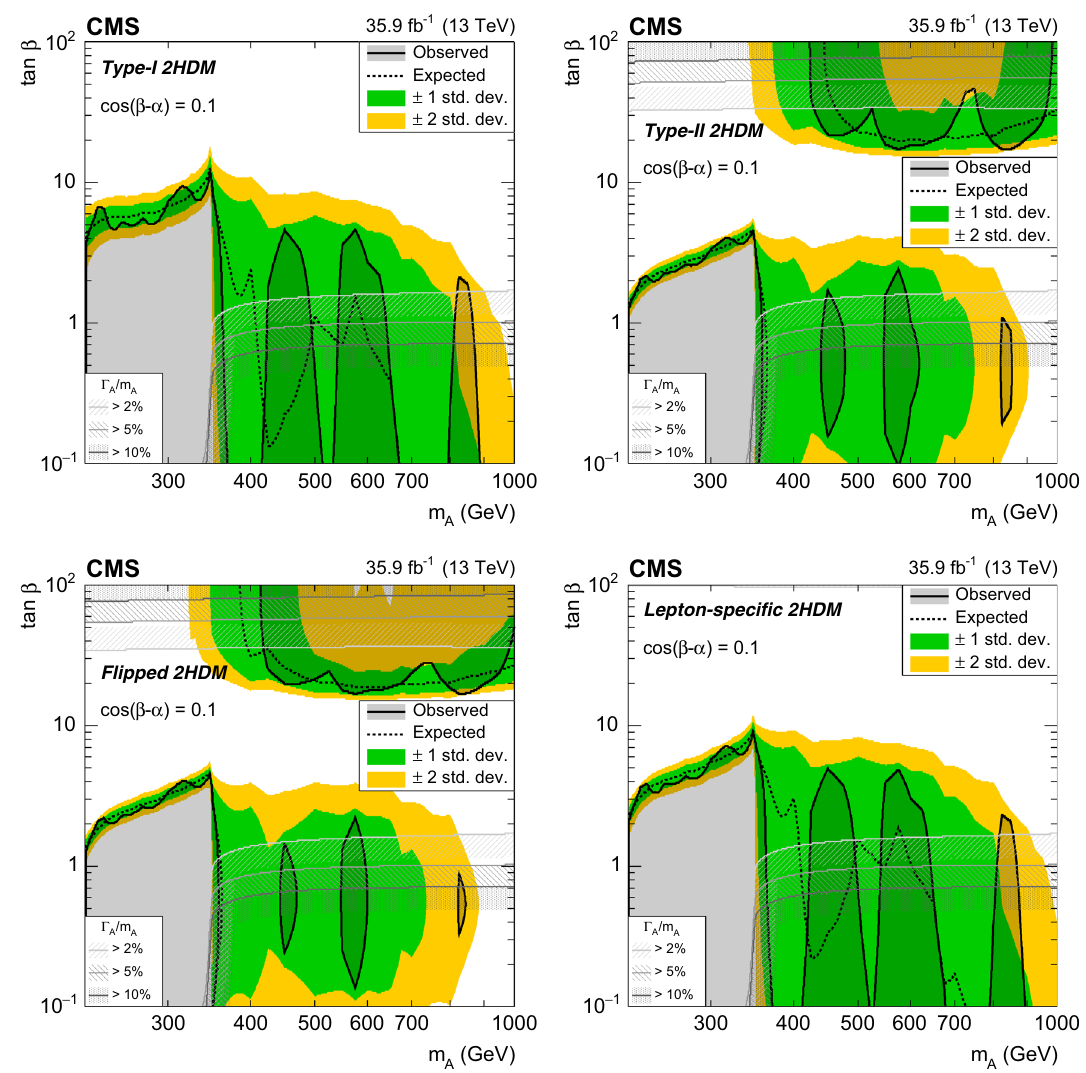
Fig. 7 Observedandexpected(with ± 1 , ± 2standarddeviationbands) exclusion limits for Type-I (upper left), Type-II (upper right), flipped (lower left), lepton-specific (lower right) models, as a function of m A and tan β , fixing cos (β − α) = 0 . 1. The excluded region is represented